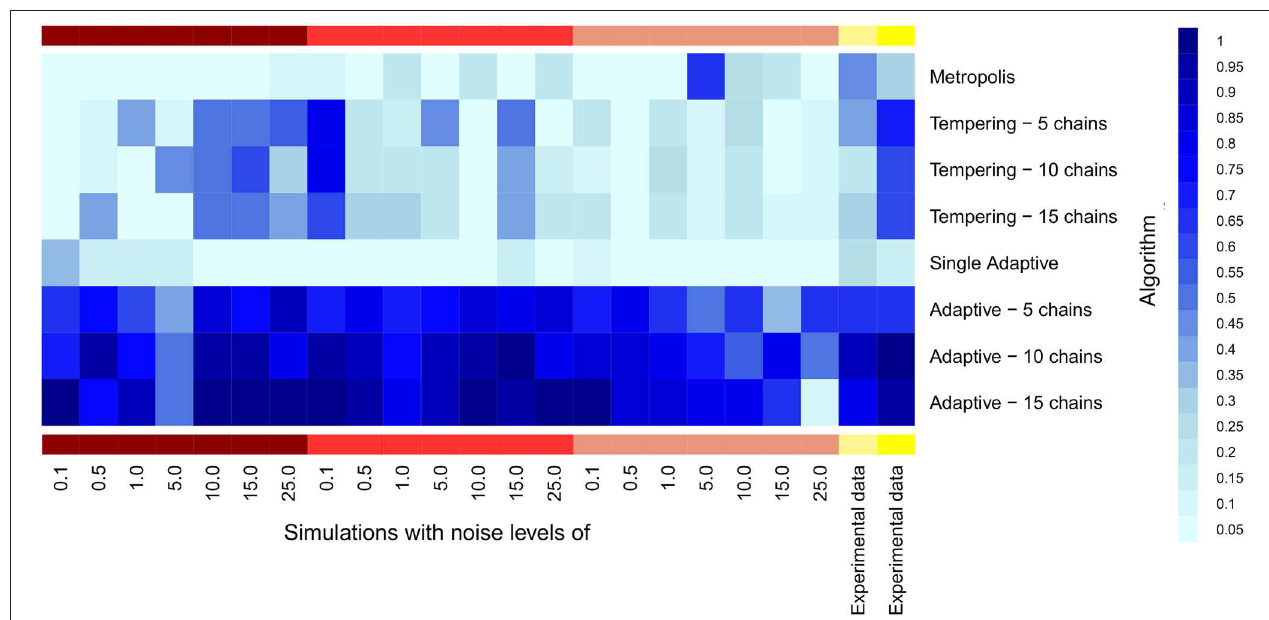
FIGURE 7 | Heatmap for the fraction of true parameters lying into the 95% Bayesian credible interval of MCMC samples. Samples were estimated by single and multiple parallel MCMC. X-axis is labeled with noise levels used in the fiver models (dark red color bar, model 1; red, model 2; light red, model 3; light yellow, model 4; yellow, model 5).